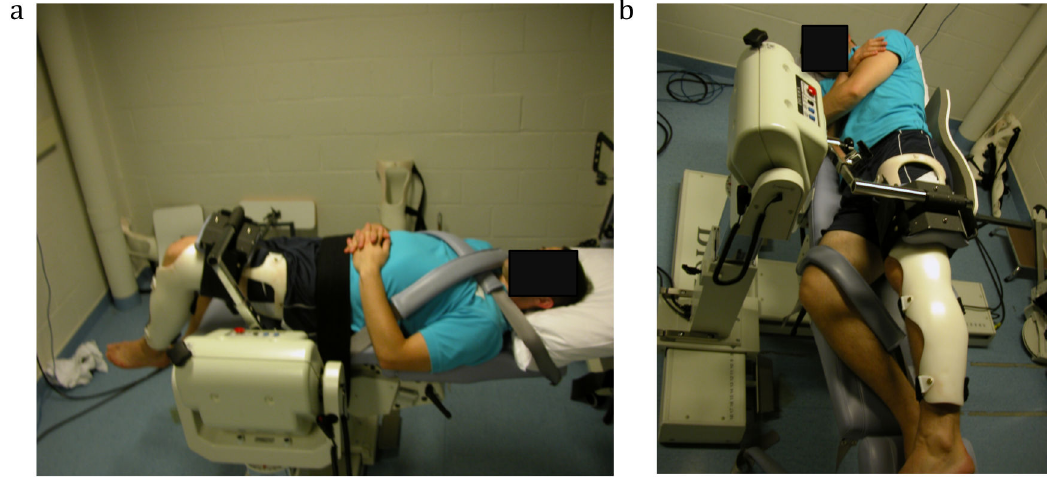
Figure 1. Protocol setup. a) On the left hand side, hip flexion setup and b) on the right hand side, hip abduction setup. doi: